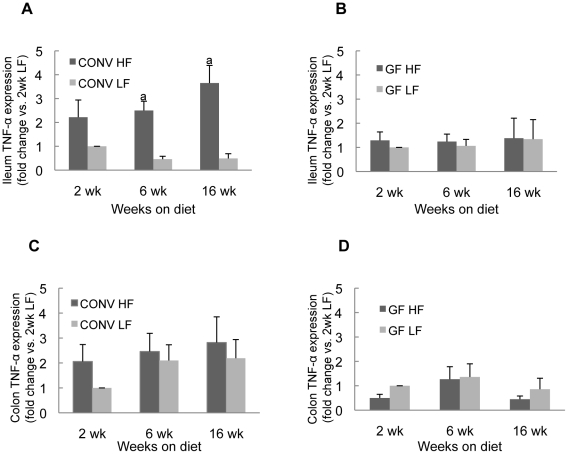
TNF-α mRNA levels in intestine of CONV or GF mice on HF/LF diet.Histograms show mean ± SE expressed as fold change vs the mean mRNA level in mice fed LF diet for 2 weeks. a: P<0.05 vs CONV LF diet group.